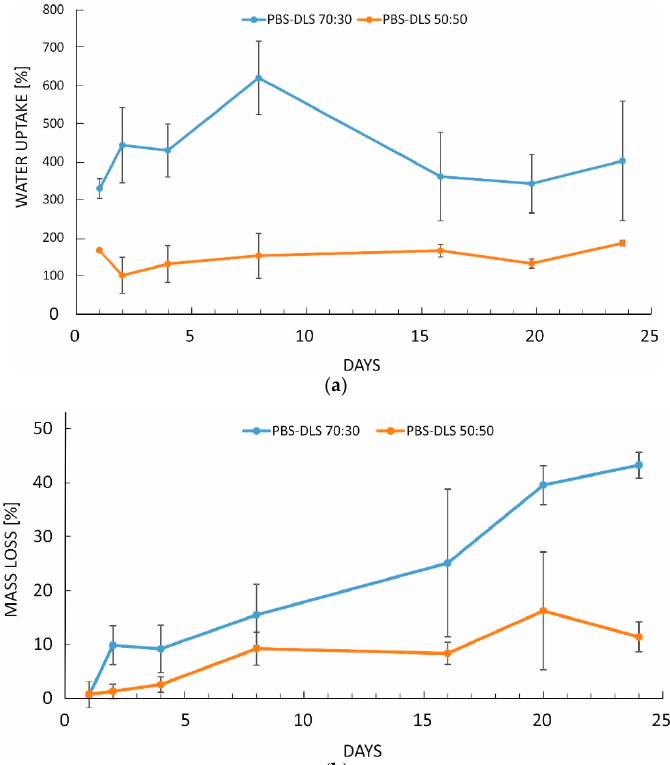
Figure 3. Water uptake ( a ) and mass loss ( b ) for electrospun fiber mats of PBS-DLS 70:30 and PBS-DLS 50:50 (mean ± SD, n = 3).